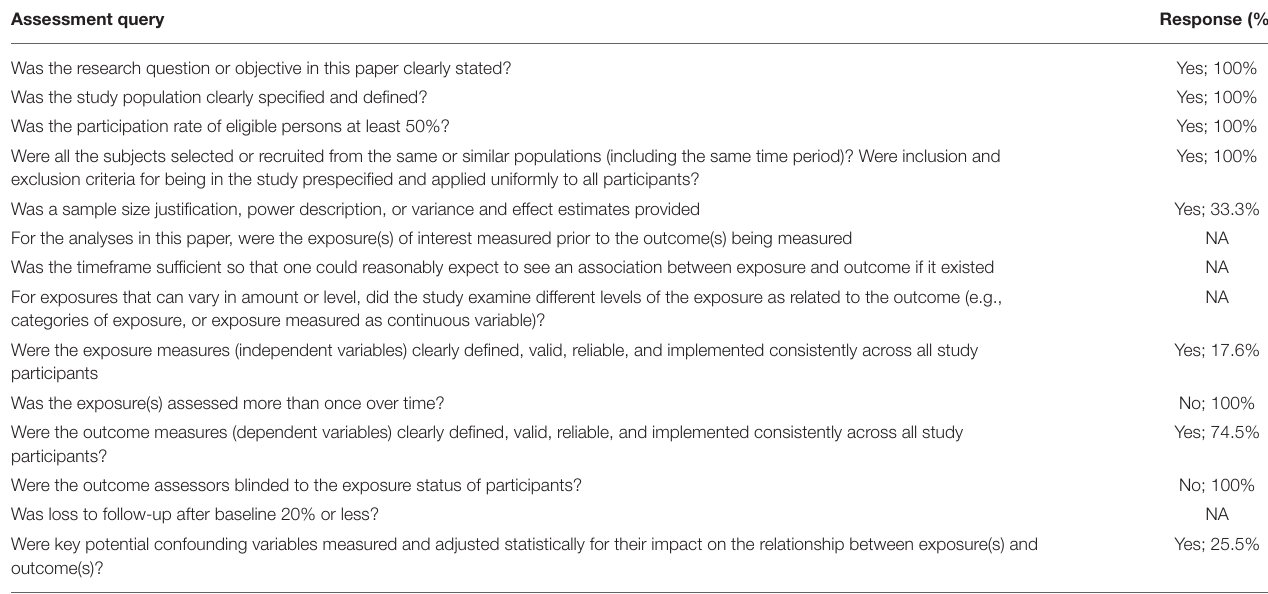
TABLE 2 | Summary of NHLBI quality assessment.